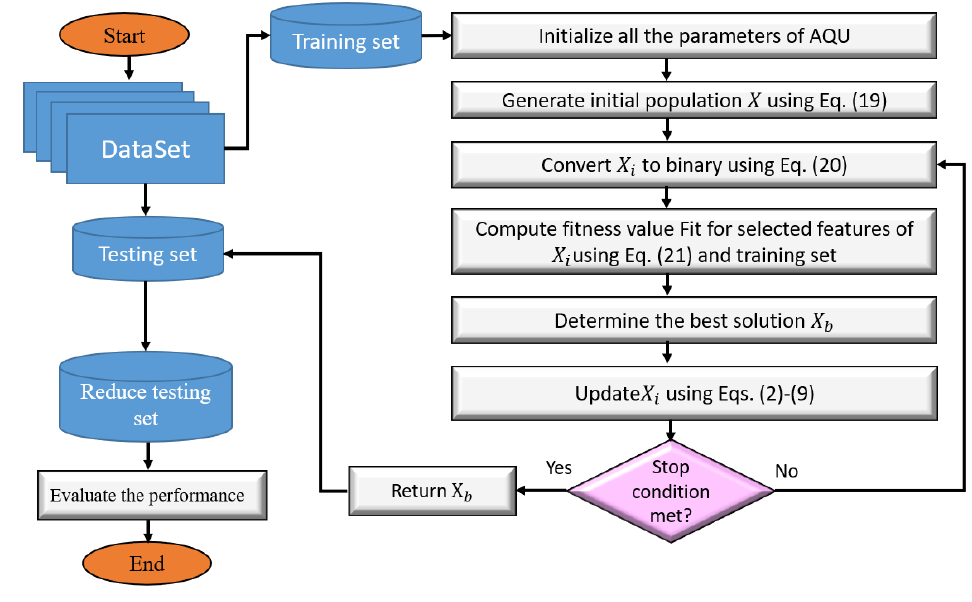
Figure 3. The FS approach using AQU